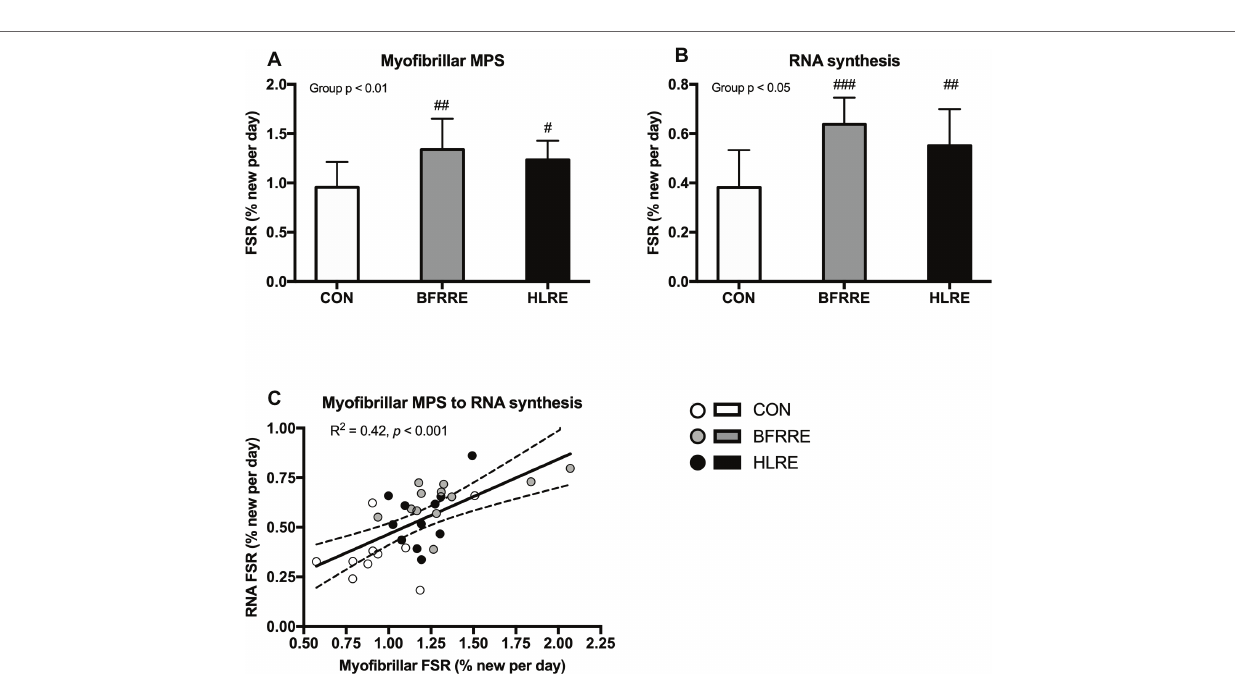
FIGURE 3 | Myofibrillar protein (A) and RNA (B) synthesis rates (%/day) during the intervention period. Correlation between myofibrillar FSR and RNA FSR (C) . Data are presented as mean ± SD in (A,B) . In (C) , data are presented as individual values and a linear regression line (solid) with 95% CI (dashed). Overall group effect is given in the upper left corner of graphs of (A) and (B) . R square and significance is given in the upper left corner of (C) . # p < 0.05, ## p < 0.01, and ### p < 0.001 different from